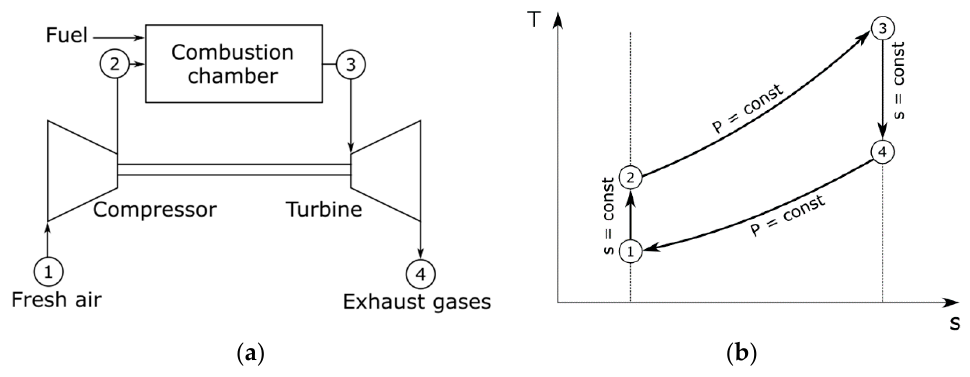
Figure 6. ( a ) Equipment and ( b ) T-s diagram of the ideal Brayton cycle.